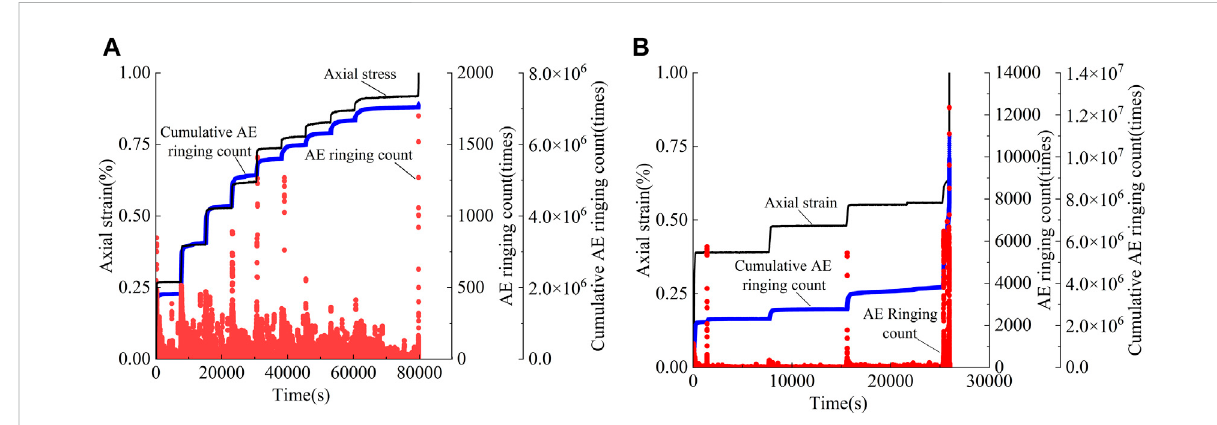
FIGURE 10 Axial strain-AE ringing count-cumulative AE ringing count-time curves of specimens. (A) Intact specimen. (B) Prefabricated fi ssures specimen.